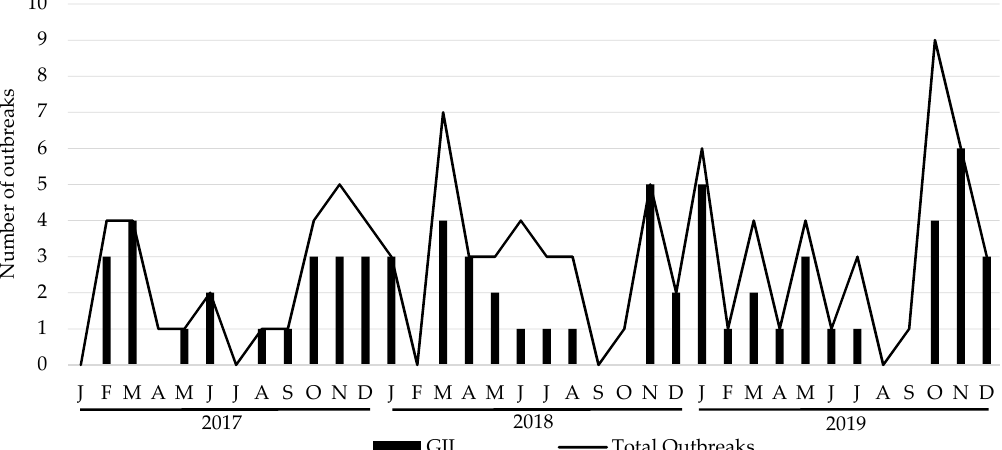
Figure 1. Monthly distribution of total and GII number of HuNoV outbreaks, 2017–2019. J: January; F: February; M: March, A: April; M: May; J: June; J: July; A: August; S: September; O: October; N: